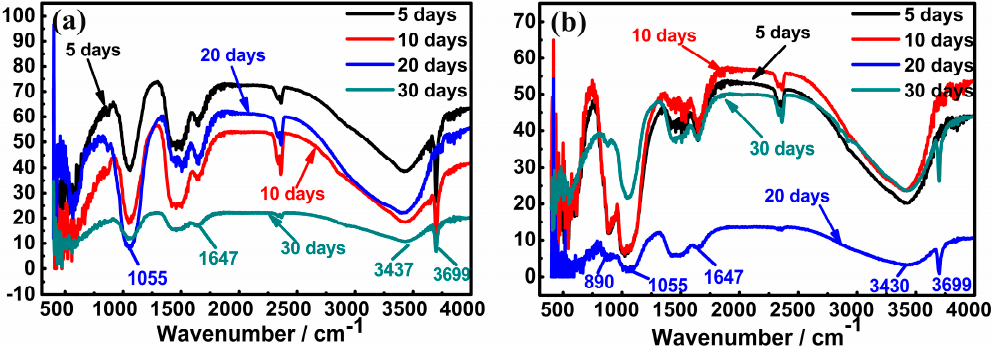
Figure 8. Fourier transform infrared spectroscopy (FTIR) of corrosion products on samples: ( a ) uncoated ( b ) MAO